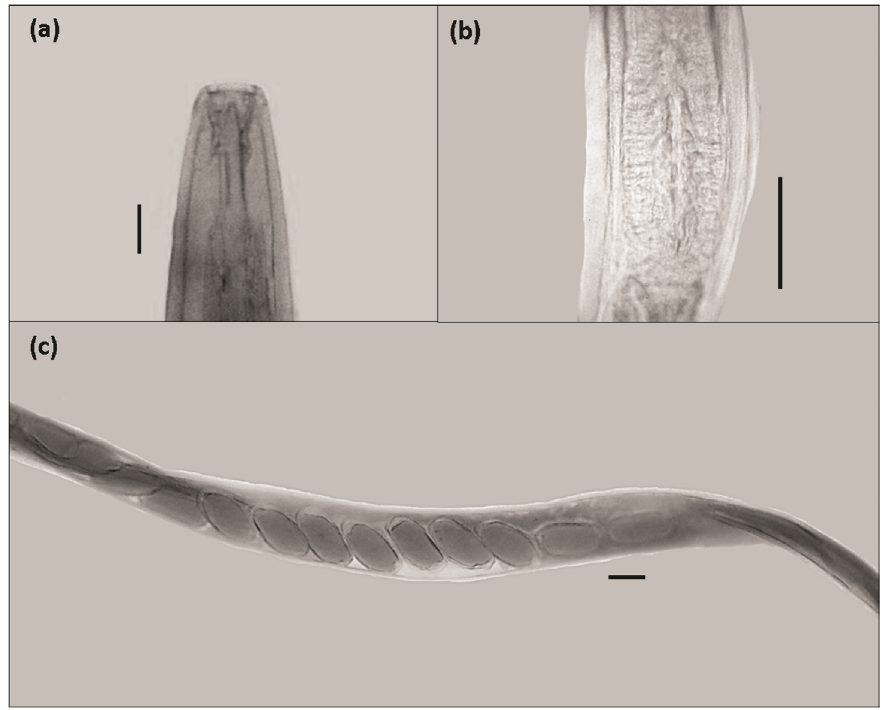
Description: Fusiform body, thin cuticle and slightly striated transversely. Bilabiate mouth, bilobed with the appearance of a tetralabiate mouth, presenting interlabies, totaling six small lips; both chitinized formations. Forelimbs are armed with sclerotized pieces; these are Figure 3. Klossinemella iheringi (Atractidae). a. Anterior end. Scale bars: 20 μm. b. Esophageal bulb. Scale bars: 30 μm. c. Gravid female eggs. Scale bars: 40